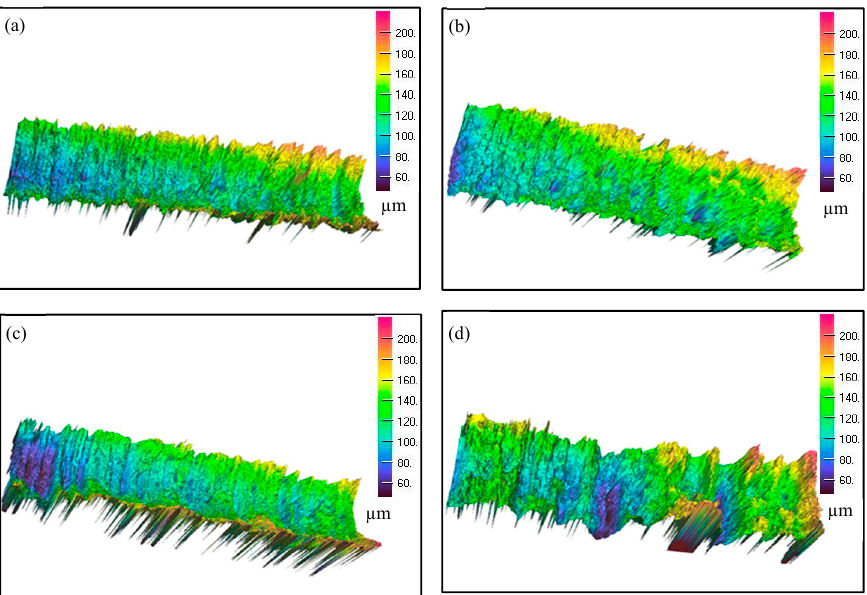
Figure 9. Three-dimensional shape of the holes internal surface of the HT250 borehole: ( a ) Φ 14.5 mm bit and ( b ) Φ 19 mm bit; QT450 borehole: ( c ) Φ 14.5 mm bit and ( d ) Φ 19 mm bit (1.6 mm measured